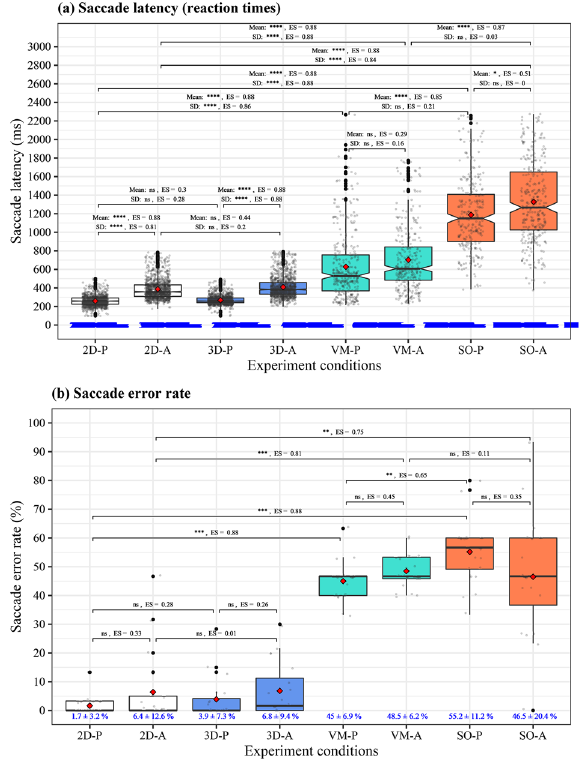
Figure 2. Distribution of saccade parameters of pro- and anti-saccades in 2D (baseline dual task condition), 3D (with visual challenge), visuospatial memory (VM), and spatial orientation (SO) VR environments. VM and SO tasks significantly affected ( a ) Latency (reaction times) and ( b ) Error rate. P Pro-saccade task, A Anti-saccade